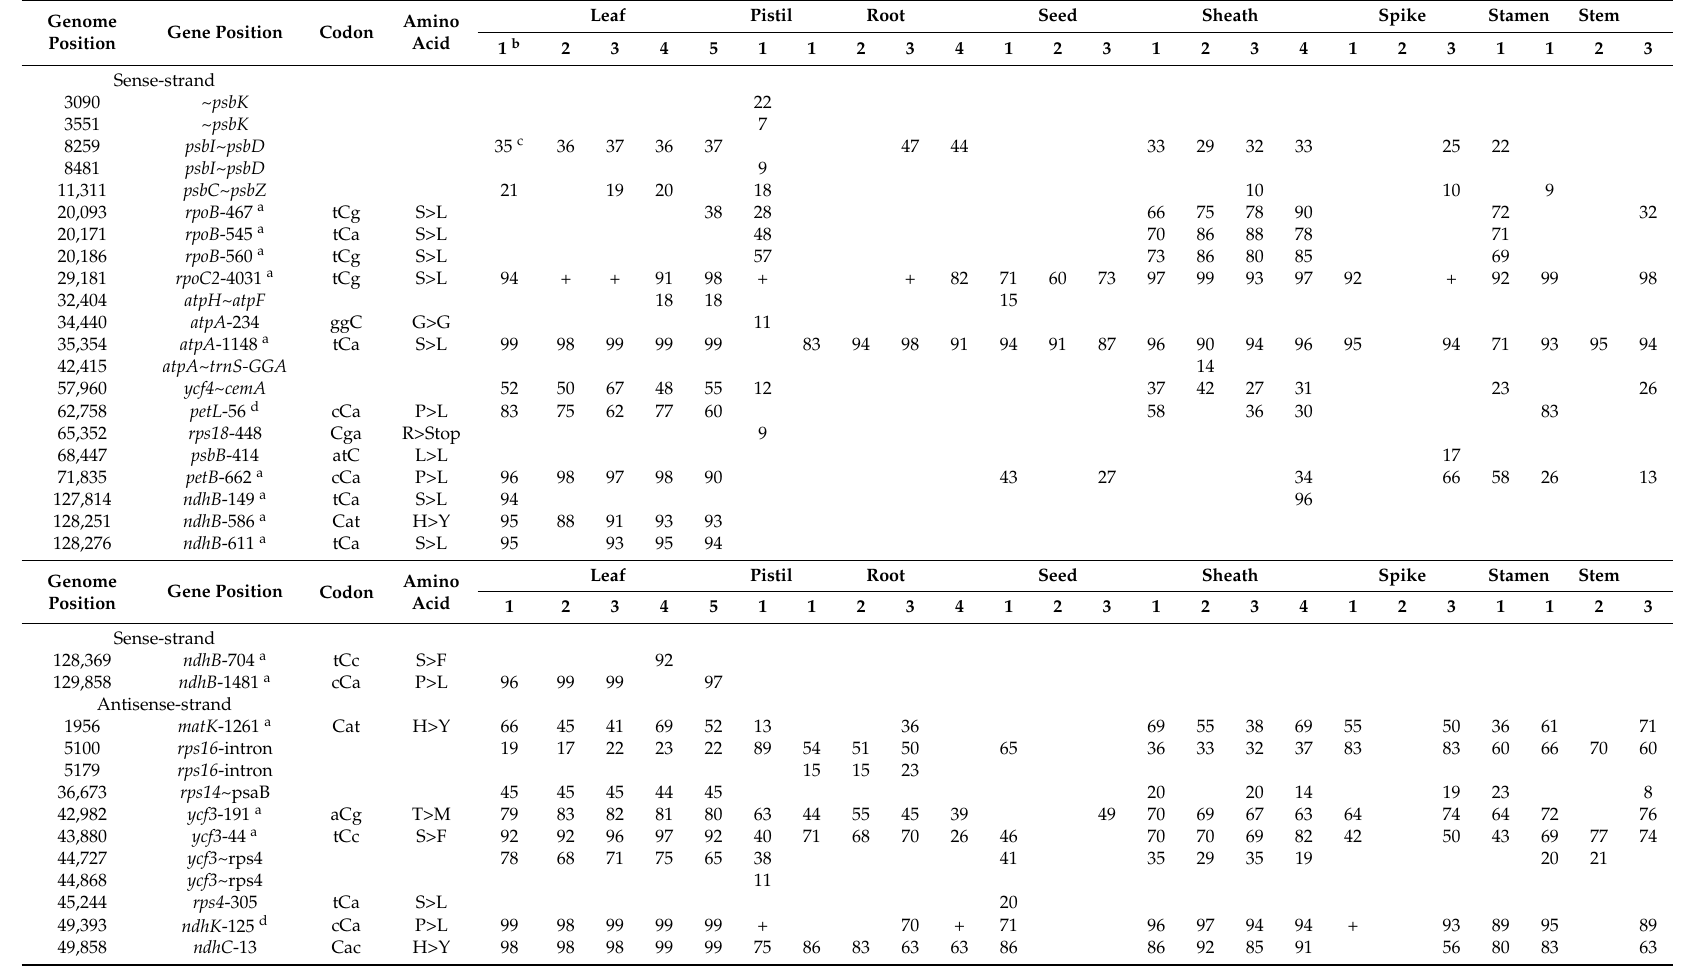
Table 3. Cytidine (C) to uridine (U) editing sites in chloroplast genome of Ae. tauschii (AL8/78) validated by RNA-Seq